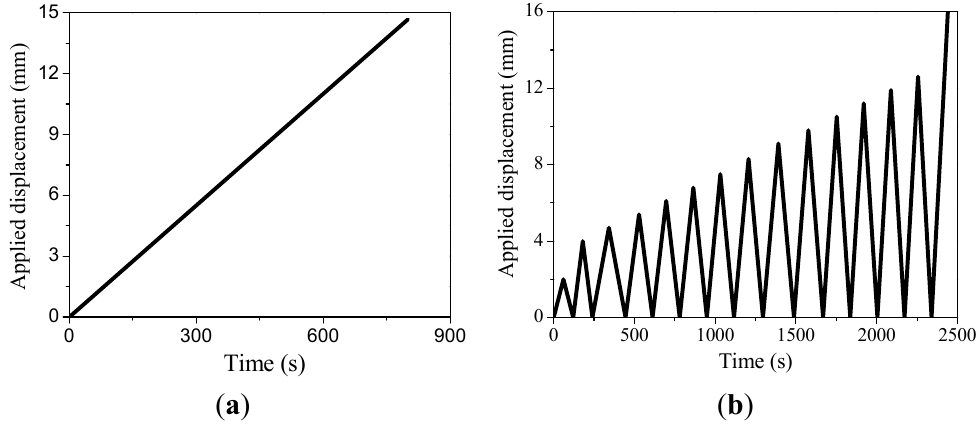
Figure 4. Loading programs of ( a ) the uniaxial tensile test and ( b ) the cyclic tensile test.